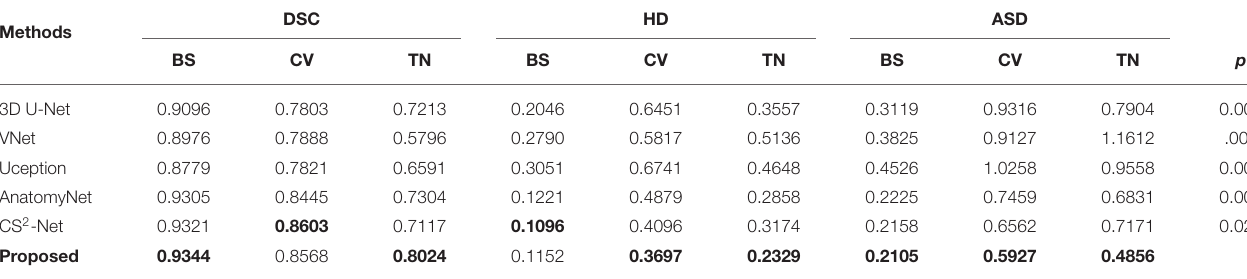
TABLE 1 | Segmentation performance of comparison methods on MRA